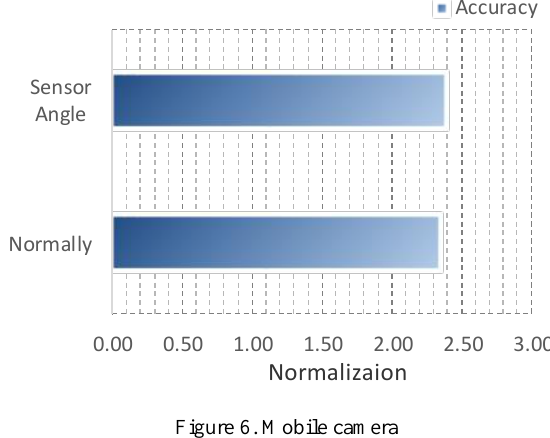
Figure 6. Mobile